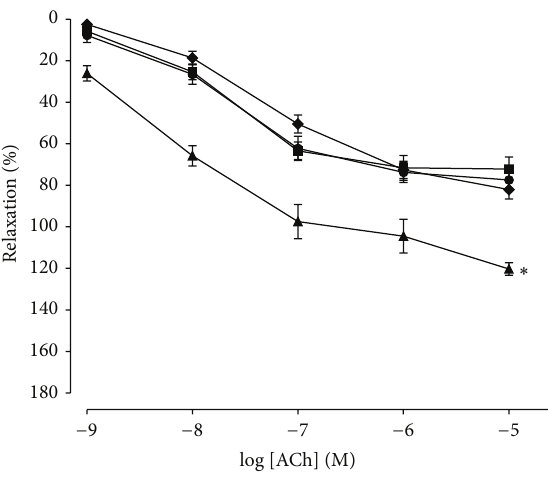
Figure 2: ACh-induced relaxation responses of aortic rings pre- contracted with PE (1 𝜇 M) in control ( ◼ ), losartan ( 󳵳 ), WOS ( ∙ ), and WMOS ( Q ). Responses to ACh are expressed as percentage of relaxation. Values are mean ± SEM of 5 to 8SHRs in each group. ∗ Denotes 𝑃 < 0.05 compared to